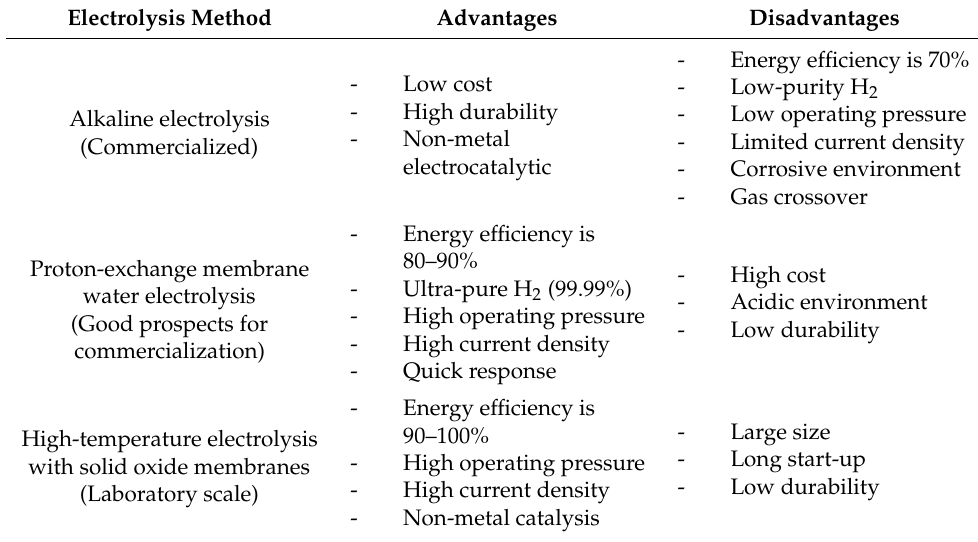
Figure 11. The main types of electrolysis methods: ( a ) proton-exchange membrane water electrol- ysis; ( b ) alkaline electrolysis; ( c ) high-temperature electrolysis with solid oxide membranes; and ( d ) microbial electrolysis. Table 4. Comparison of different water electrolysis methods.